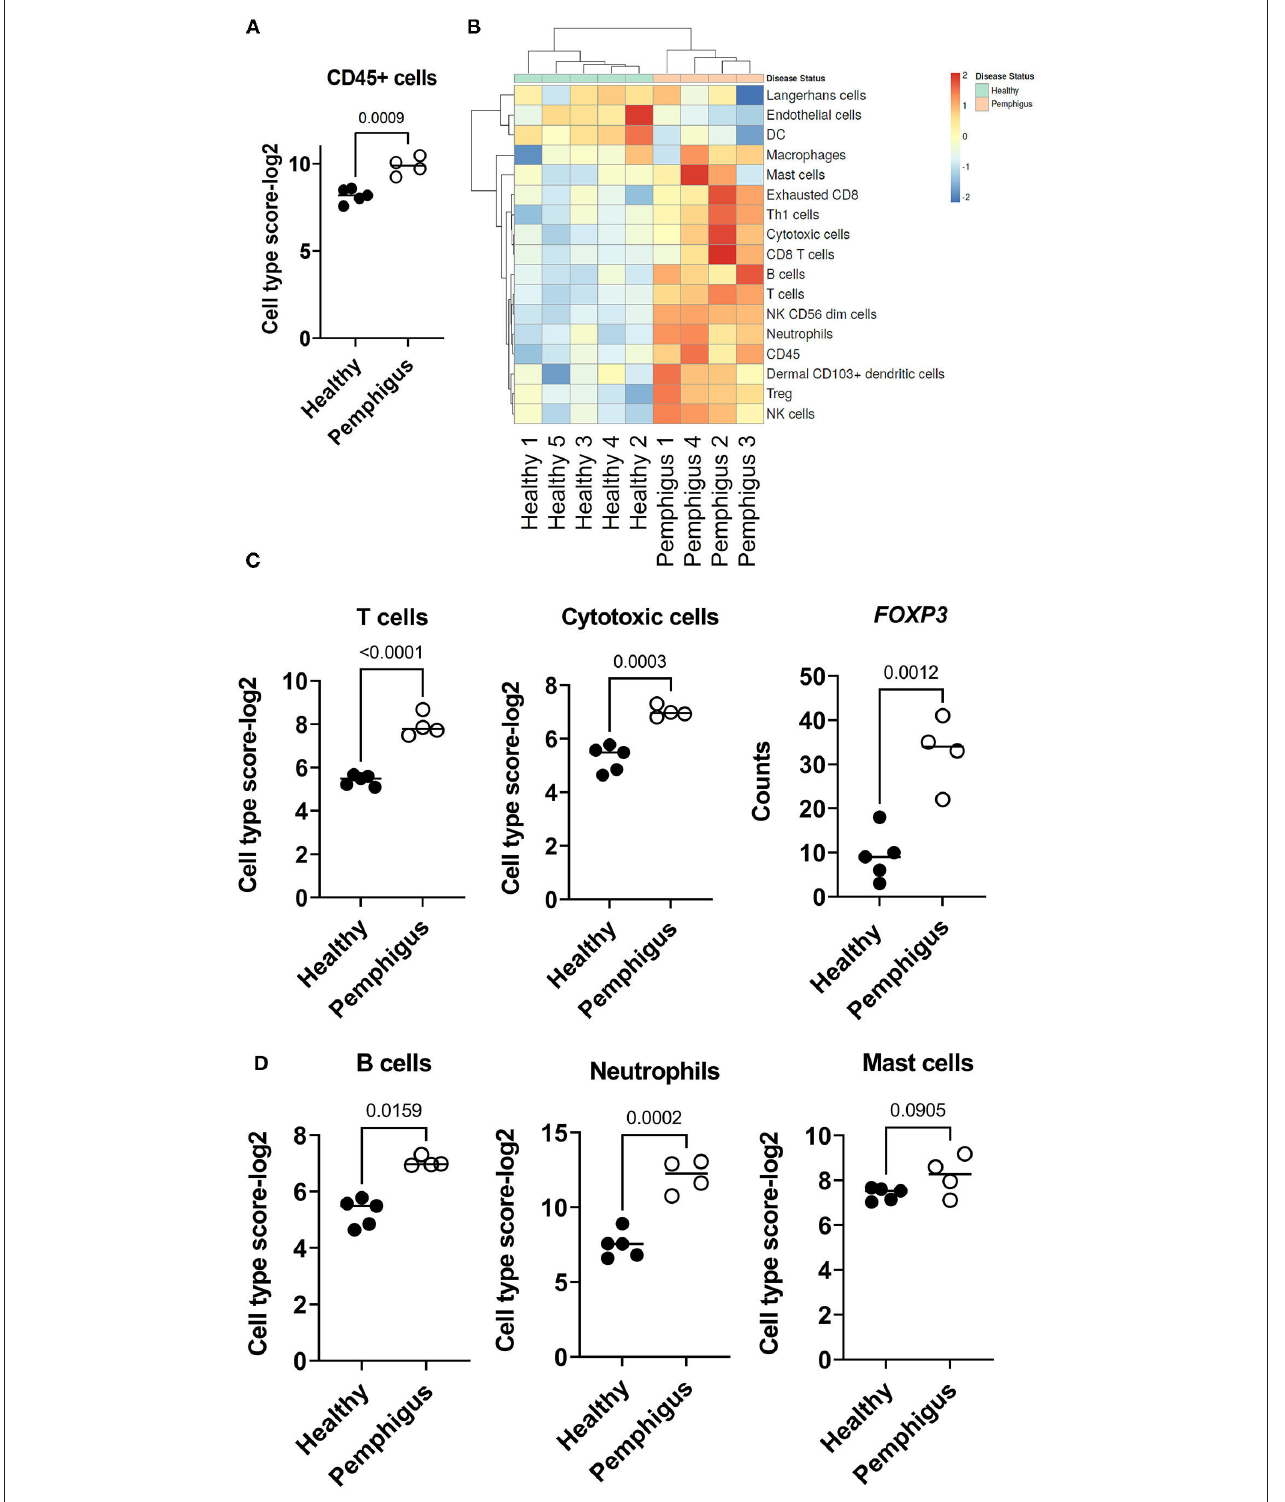
FIGURE 3 | Cell type enrichment scores in canine pemphigus reveals infiltrations of T, B, NK cells, and neutrophils. (A) Total CD45 + infiltrates were significantly higher in cases vs. healthy margins. (B) Heatmap of cell type scores in healthy (green) and pemphigus (orange) samples. (C) Cell type scores from NanoString